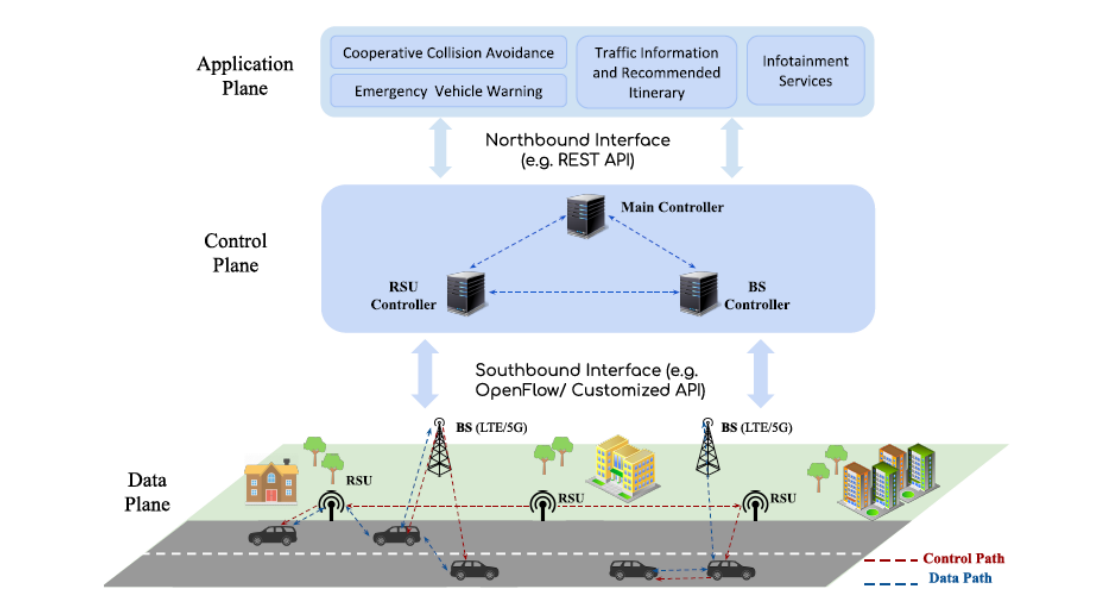
Figure 1. Conceptual view of Software Defined Vehicular Network (SDVN)